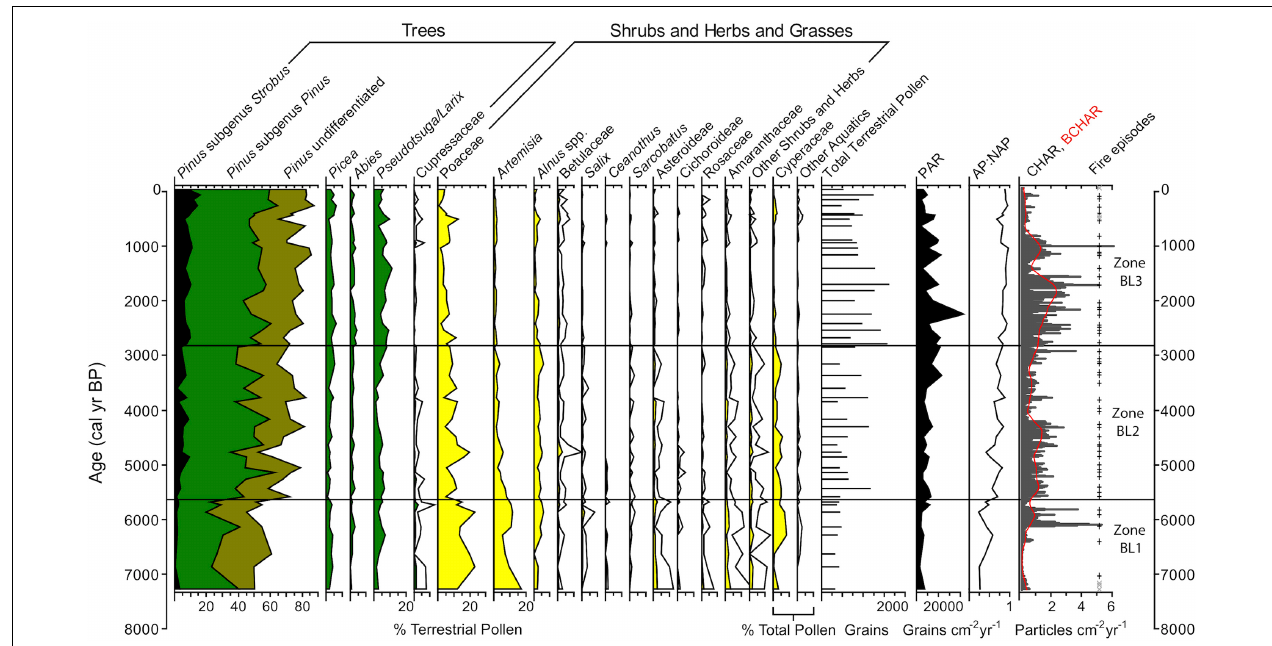
FIGURE 4 | Pollen percentage data for select taxa, arboreal/non-arboreal pollen ratio (AP:NAP), and charcoal accumulation data from Black Lake sediments. Pinus pollen data are stacked percentages. White outlines represent 5x exaggeration.